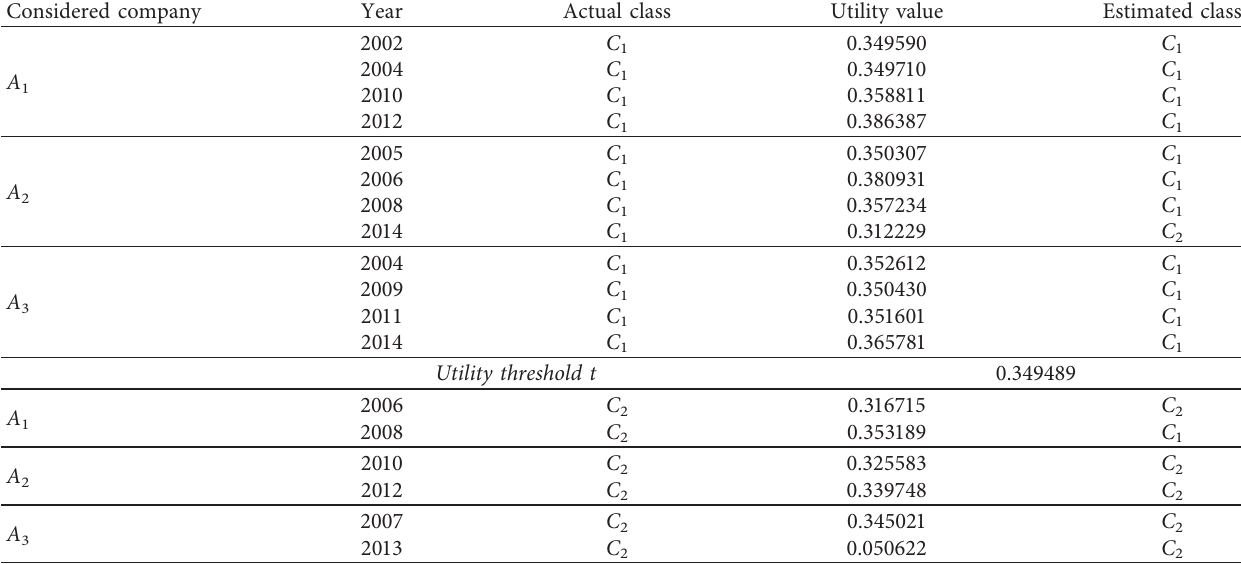
Table 4: Forecasting results with the trained SM-UTADIS model (testing dataset).